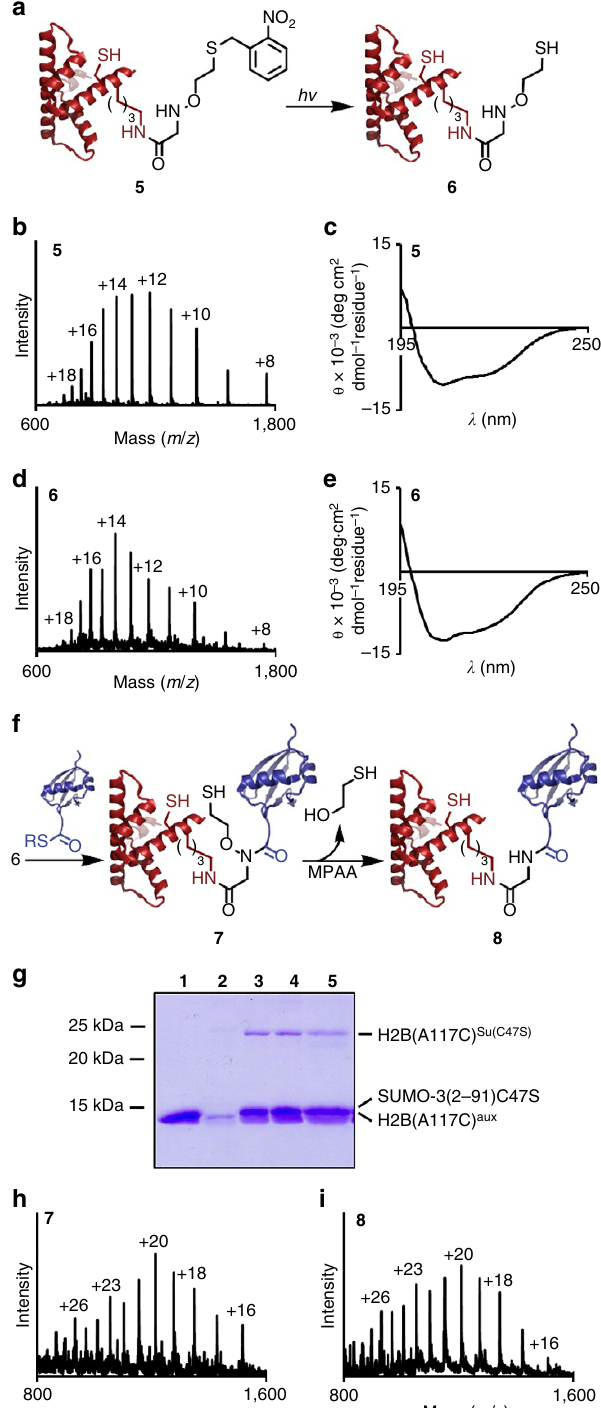
( 8 ) under folded conditions. ( g ) Coomassie-stained 15% SDS– ( 6 ) and SUMO3(2–91)C47S- a -thioester under non-denaturing